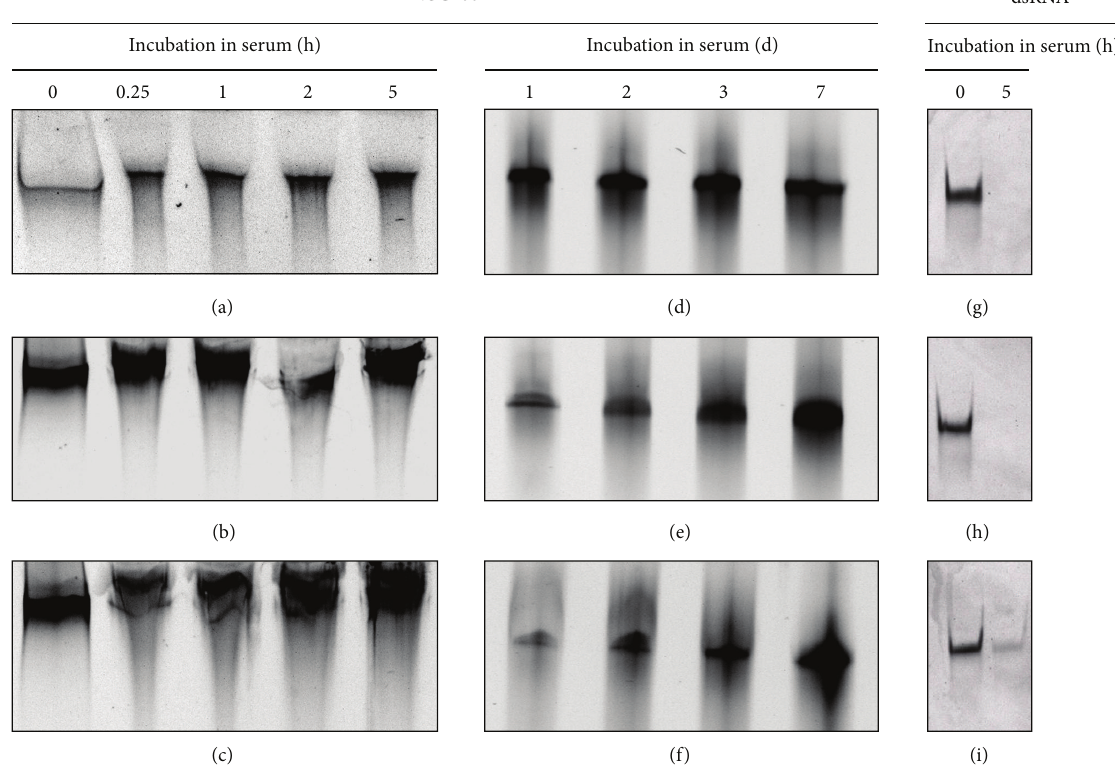
Figure 2: Assessment of the stability of RGC100 in FCS, mouse serum, or human serum. RGC100 (1.6 𝜇 M) was incubated in 80% serum at 37 ∘ C and samples were analyzed on 12% native PAGE at indicated time points (h, hours and d, days). The corresponding untreated dsRNA (0h) is shown as a reference. (a) Incubation of RGC100 in FCS up to 5 h. (b) Incubation of RGC100 in mouse serum up to 5 h. (c) Incubation of RGC100 in human serum up to 5 h. (d) Incubation of RGC100 in FCS up to 7 days. (e) Incubation of RGC100 in mouse serum up to 7 days. (f) Incubation of RGC100 in human serum up to 7 days. (g) Incubation of dsRNA (25bp) used as a control in FCS for 5 hours. (e) Incubation of dsRNA (25 bp) used as a control in mouse serum for 5 hours. (f) Incubation of dsRNA (25 bp) used as a control in human serum for 5